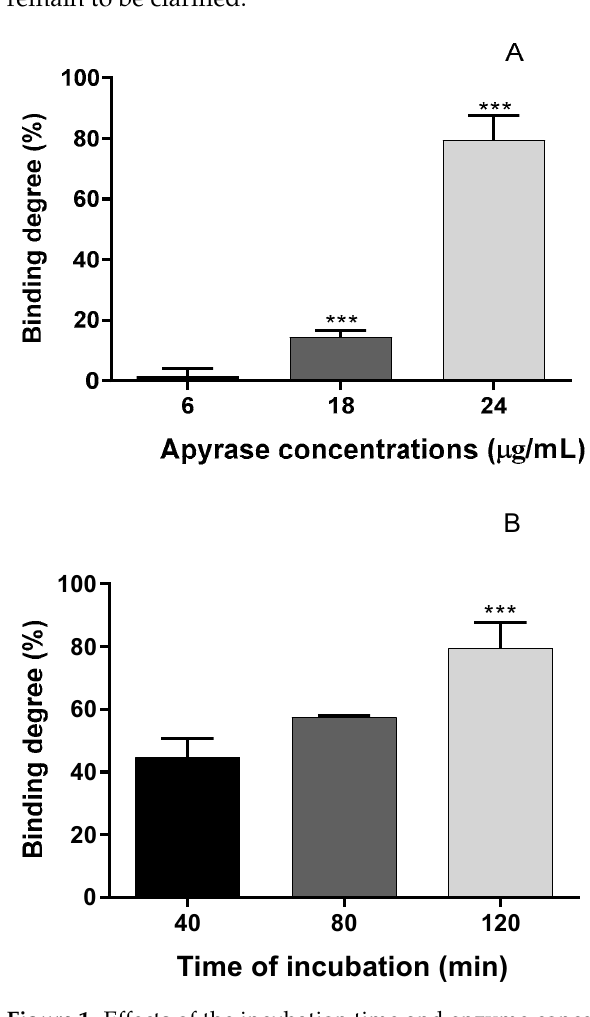
Figure 1. Effects of the incubation time and enzyme concentration on the binding ability between cardamonin and apyrase. ( A ) Binding degrees of cardamonin with apyrase at different concentrations. Cardamonin incubated with 6, 18, and 24 µg/mL of apyrase; *** p < 0.001 compared with group of 6 µg/mL of apyrase using the Dunnett’s multiple-comparison test. ( B ) Binding degrees of carda- monin with apyrase at different incubation times. *** p < 0.001 compared with group apyrase 40 min using the Dunnett’s multiple-comparison test. Table 1. Chemical characterization of C. erecta ultrafiltrates by